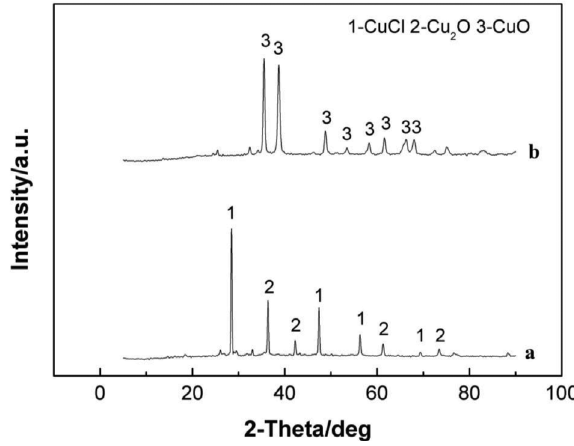
Figure 7: XRD pattern of samples before and after microwave roast- ing: (a) samples before microwave roasting and (b) samples after microwave